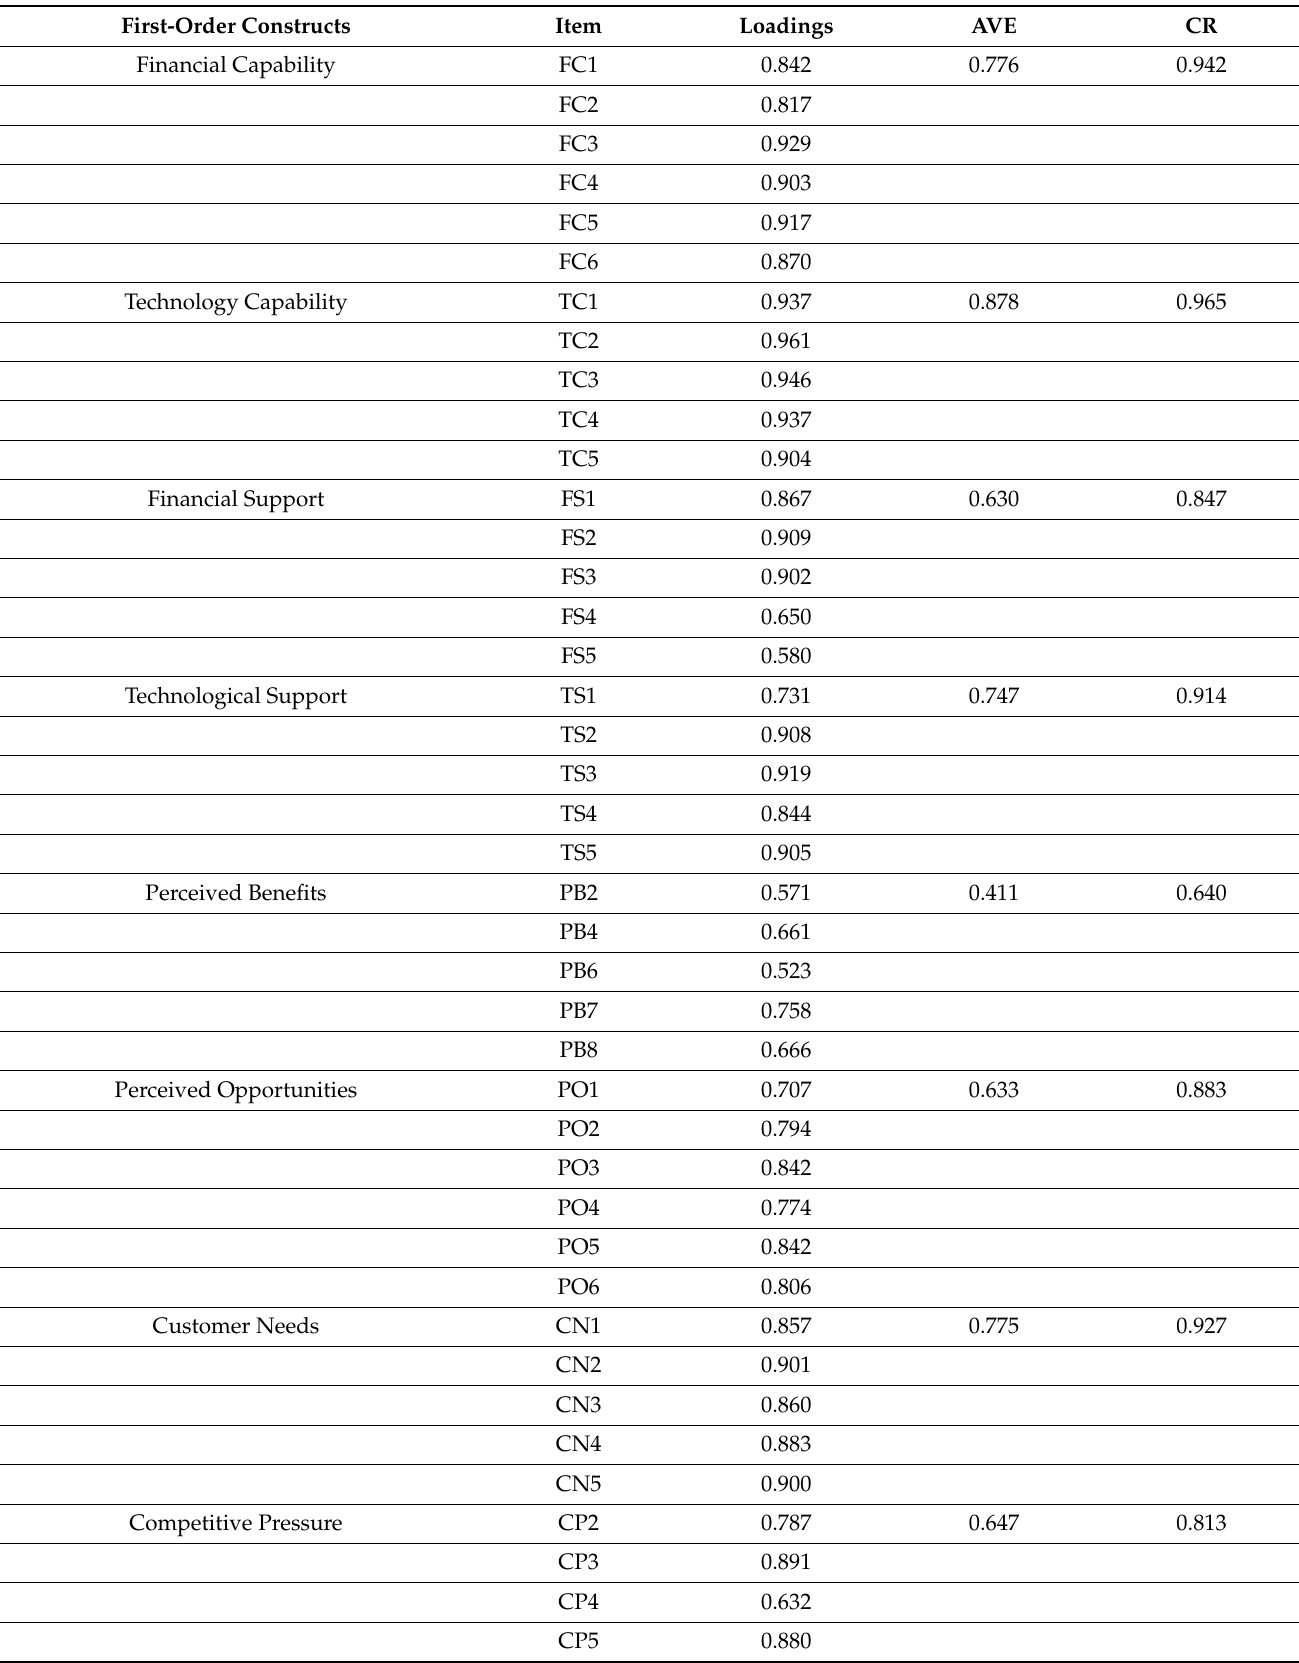
Table 9. Measurement model for first-order